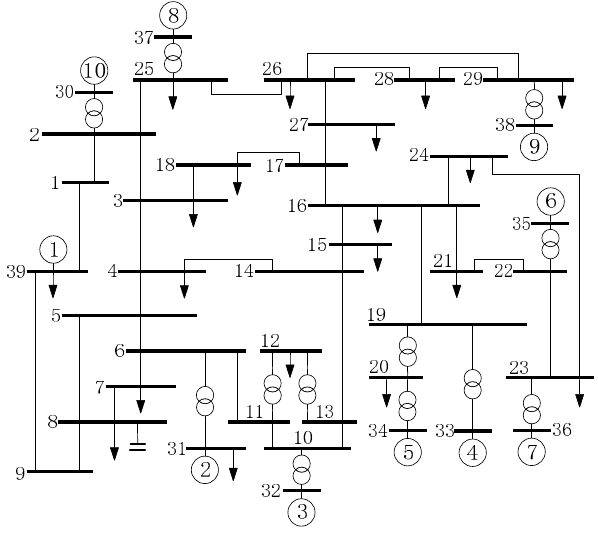
Figure 10. New England 39-bus test system.